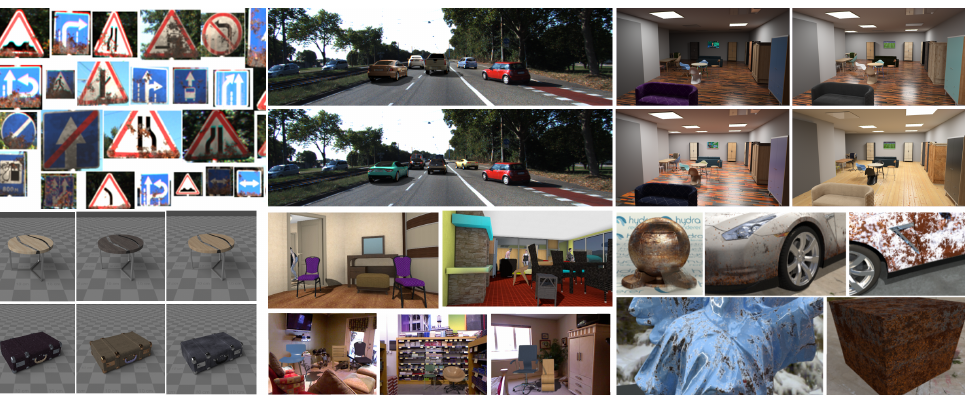
Figure 1. Examples of our applications. Road signs and cars were rendered as individual objects and then augmented to the KITTI dataset for further CNN training and testing (left and middle); realistic rendering of the interior, the 3D scenes are created randomizing of objects layout, material and lighting by our